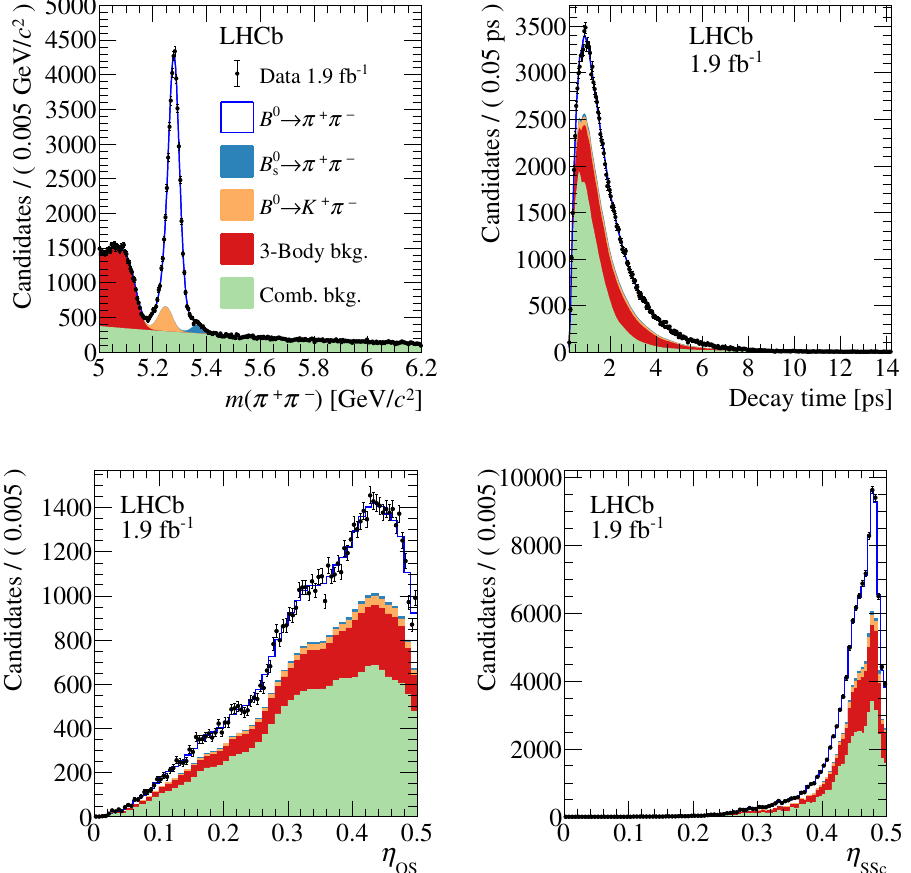
Figure 3 . Distributions of (top left) (cid:25) + (cid:25) (cid:0) invariant mass, (top right) B 0 fractions (bottom left) (cid:17) OS and (bottom) (cid:17) SSc for (cid:25) + (cid:25) (cid:0) candidates. The result of the simulta- neous (cid:12)t is overlaid. The various components contributing to the (cid:12)t model are drawn as stacked